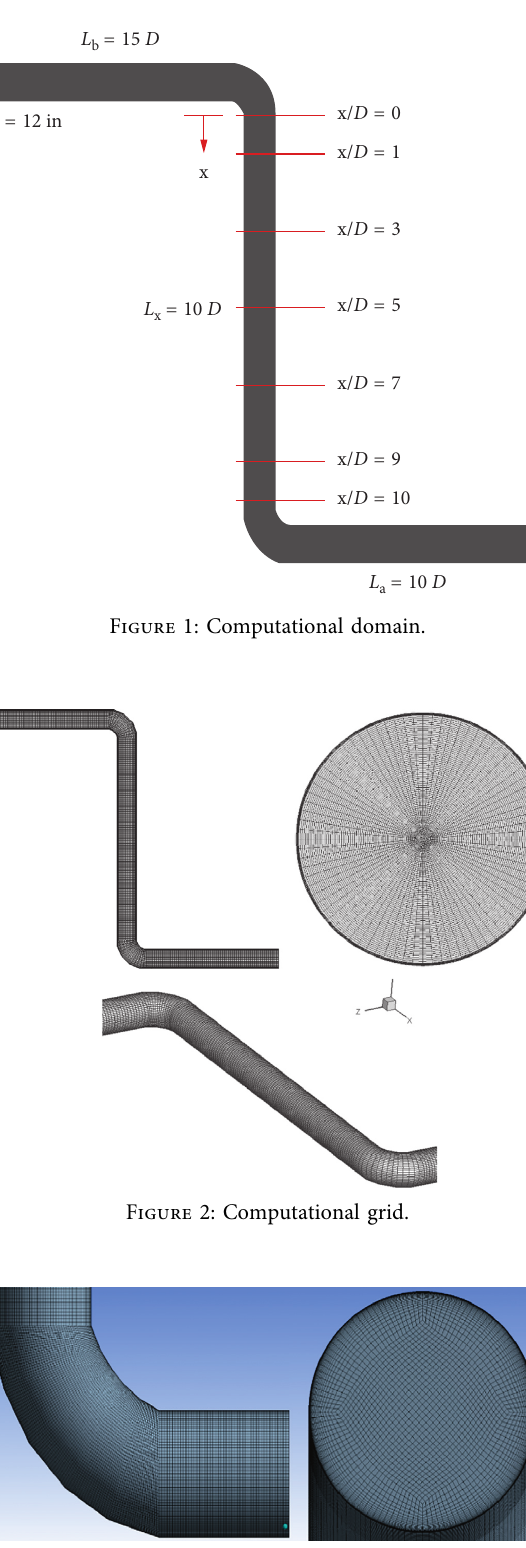
Figure 3: Duct wall and interior mesh resolutions.